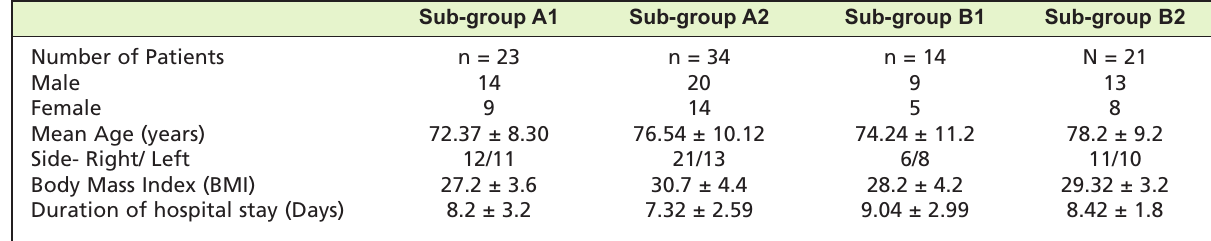
Demographic characteristics and distribution of the patients Table I: